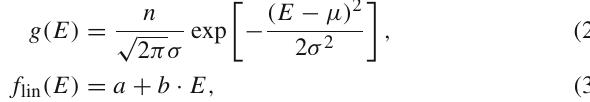
Fig. 1 Combined Phase II energy spectrum for 228 Th calibration data for all enriched detectors of BEGe, coaxial, and IC type after rebinning to 3keV. The inset shows the fit to the 2.6MeV line in the spectrum of the detector GD91A before the 2018 upgrade with 0.3keV binning,